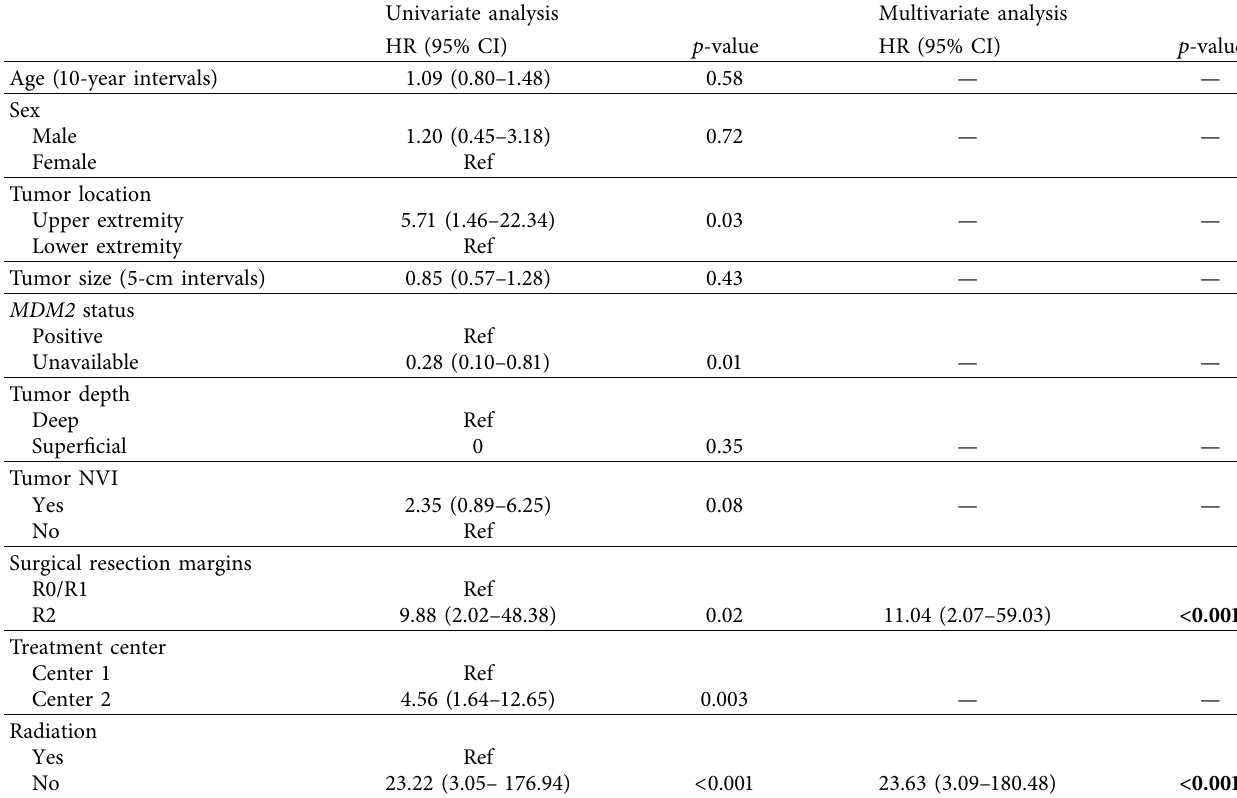
Table 3: Univariate and multivariate Cox regression analyses of patient, tumor, and treatment characteristics with recurrence.